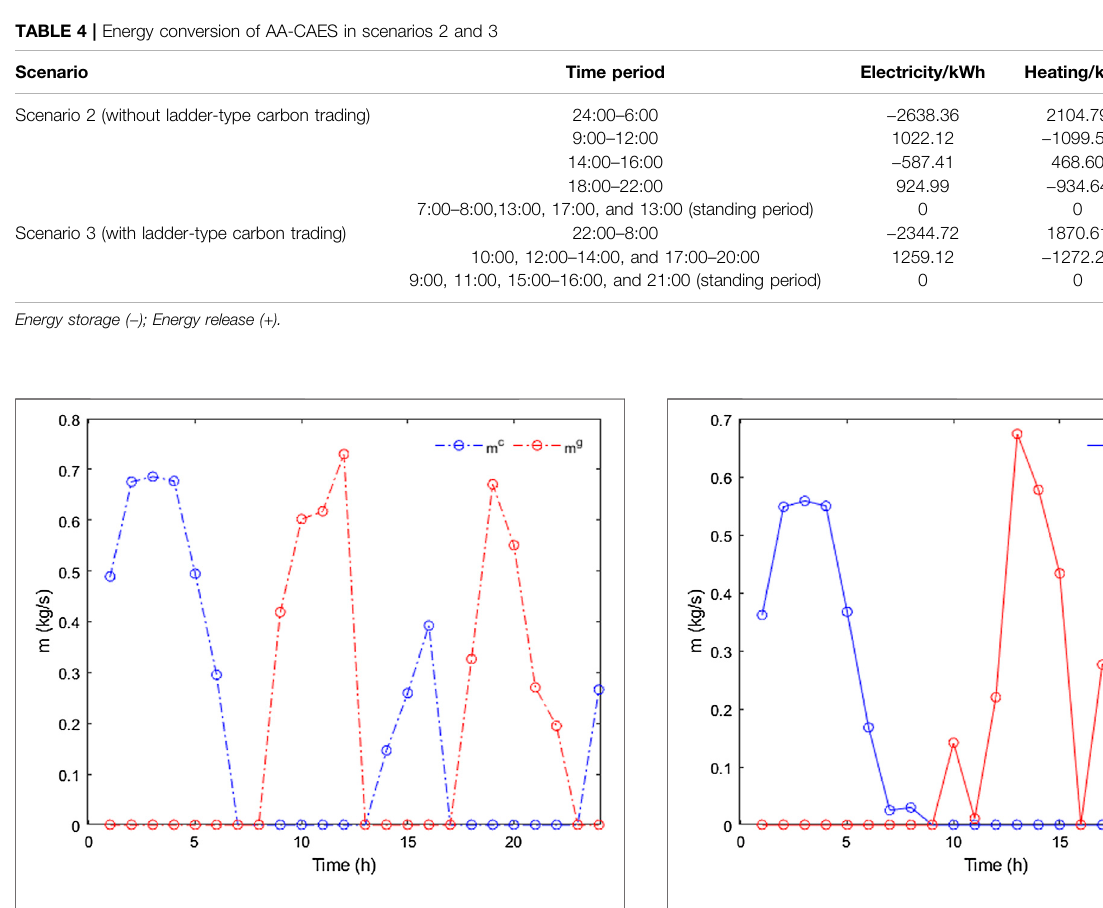
FIGURE 8 | Mass fl ow of AA-CAES in scenario 2. FIGURE 9 | Mass fl ow of AA-CAES in scenario